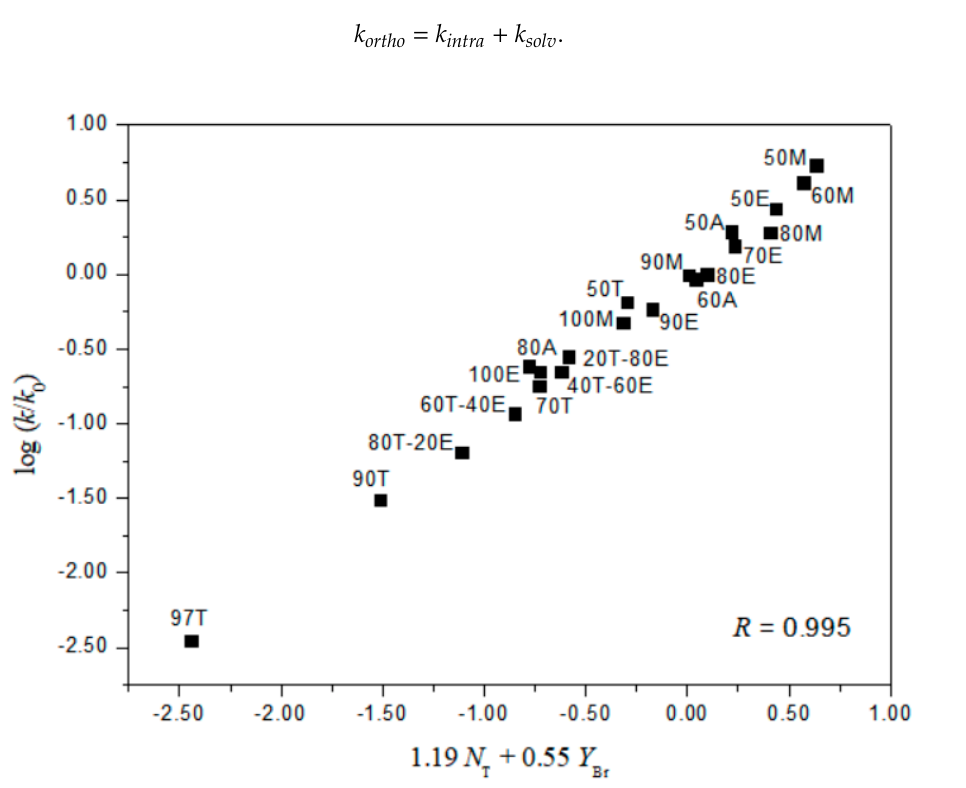
Figure 1. The plot of log ( k/k o ) p vs. 1.19 N T + 0.55 Y Br for the solvolysis of p ‐ nitrobenzyl bromide ( 3 ) in various organic solvents at 45.0 °C.